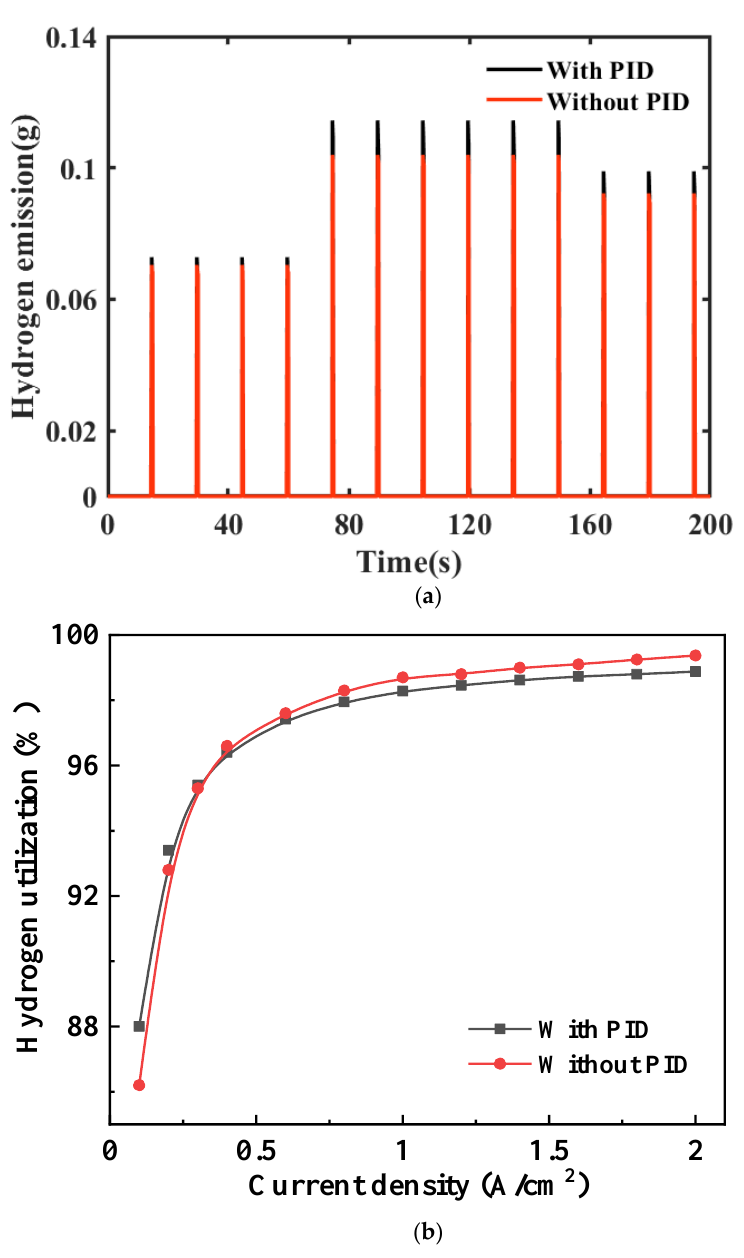
Figure 6. ( a ) The hydrogen emission quality under two control strategies. ( b ) Hydrogen utilization rate under two control modes.